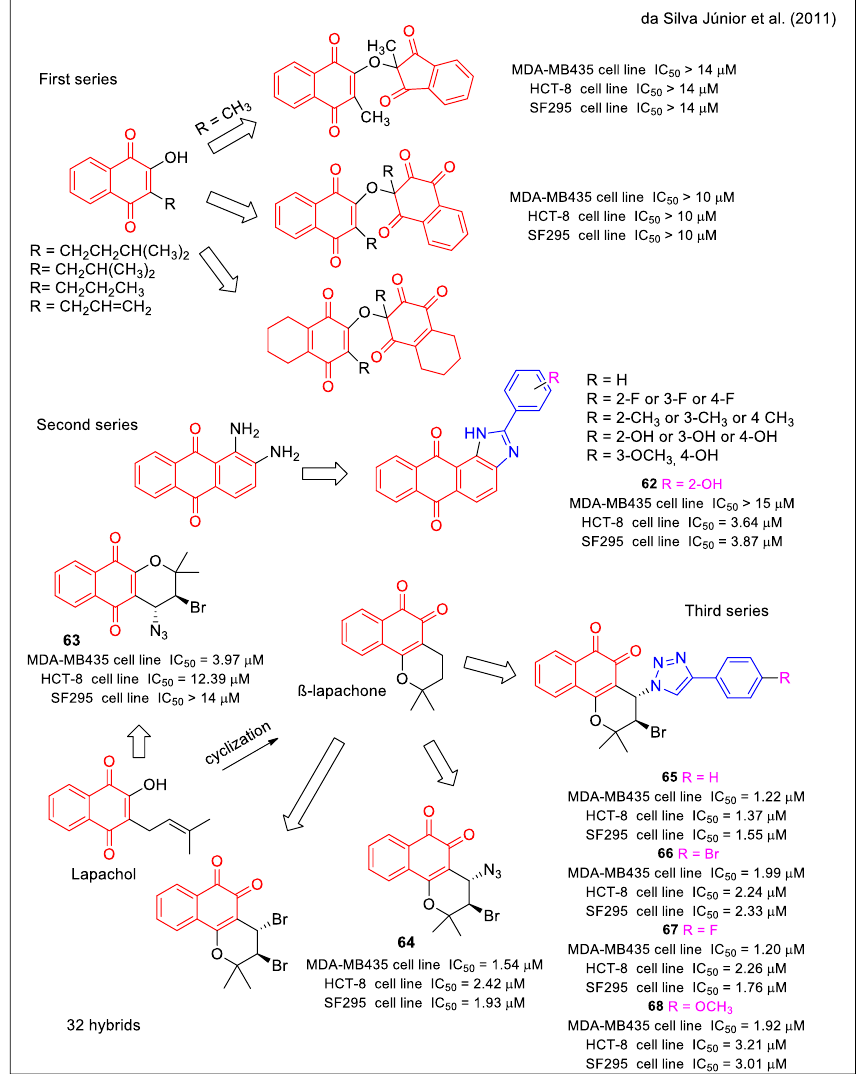
Figure 24. 1,4- and 1,2 -Naphtoquinone hybrids as reported by da Silva Júnior et al. [66]. Hybrid structures built on the nor- β -lapachone scaffold, containing the frequently used 1,2,3-triazole unit and an additional 1,4-NQ unit, were reported by Jardim et al. [67]. Selected for their intrinsic capability to generate ROS, these molecules resulted very active against four cancer cell lines, with IC 50 values lower than 2 µ M (i.e., 69 , Figure 25) but they did not show selectivity when related to normal PBMC. A second series of compounds derived by combining nor- β -lapachone and chalcone scaffolds, were synthesized using amino-functionalized chalcones with different aryl substituents. All products were highly active (i.e., 70 ) and among them the methyl analogue 71 emerged as the most promising based on its good selectivity for the HL-60 cell line, with a selectivity index even better